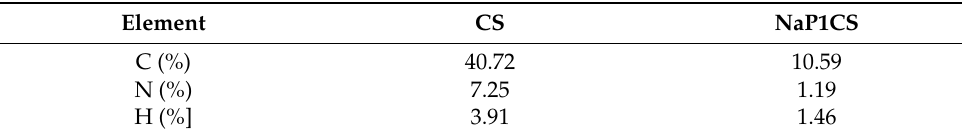
Table 2. Element analysis of CS and NaP1CS.